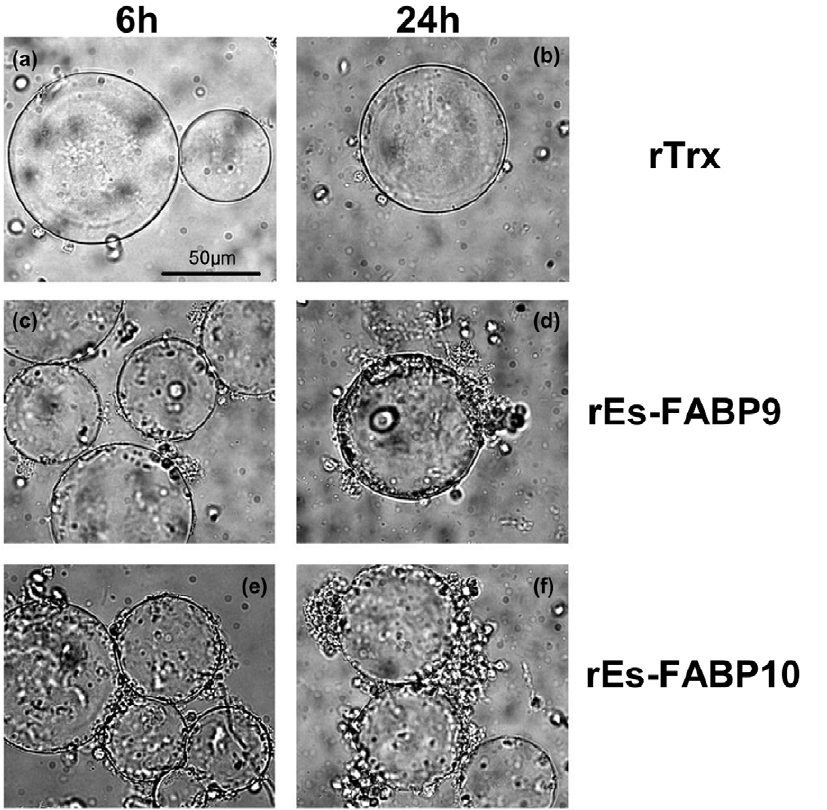
Figure 7. rEs-FABPs promote encapsulation by hemocytes. Coating with rEs-FABP9 and rEs-FABP10 and rTrx (as a control) were incubated with hemocytes for 6 h and 24 h respectively at room temperature. Encapsulation of the protein-coated beads was observed by light microscopy: (a, b) rTrx-coated beads were encapsulated by hemocytes, (c, d) rEs-FABP9-coated beads were encapsulated by hemocytes and (e, f) rEs-FABP10-coated beads were encapsulated by hemocytes. Scale bar, 50 m m.